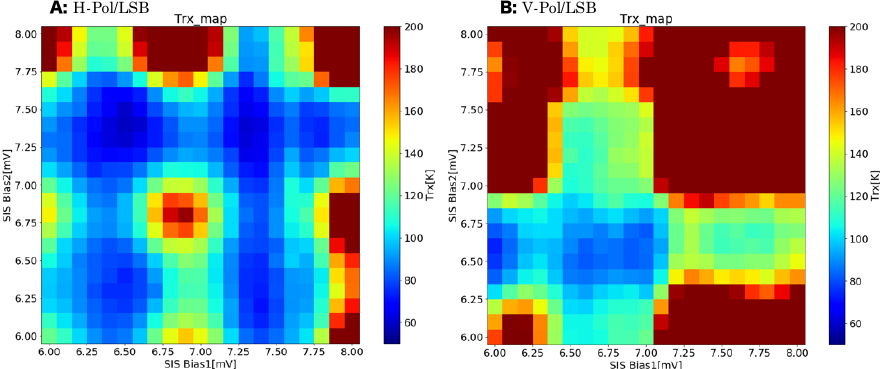
Figure 3. Results of search for optimal values of SIS-Bias yielding low T rx : ( A , B ) show the T rx maps of the two respective orthogonal polarizations without the frequency separation filter. Both the horizontal and vertical axes show the search range of the optimal bias for the SIS mixer. The color indicates the T rx obtained with each combination of SIS-Bias 1 and